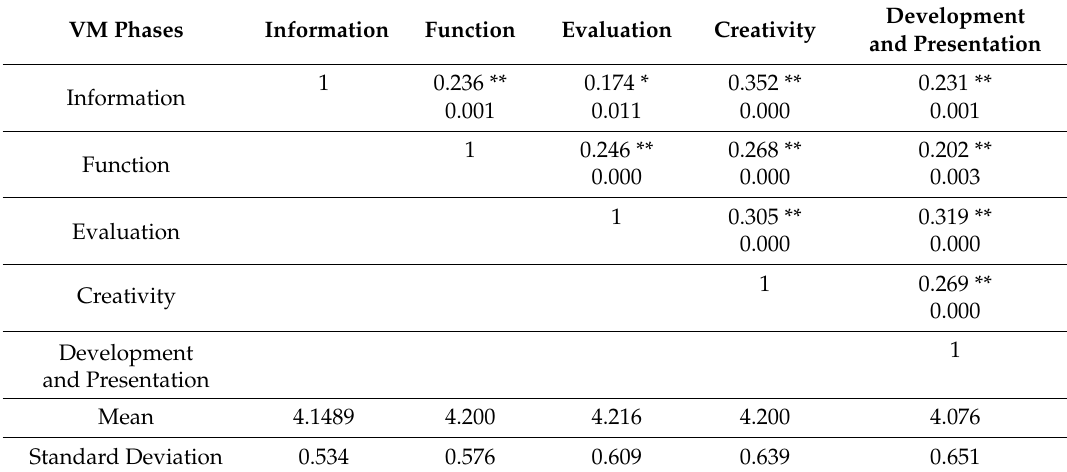
Table 4. Correlation analysis results between VM